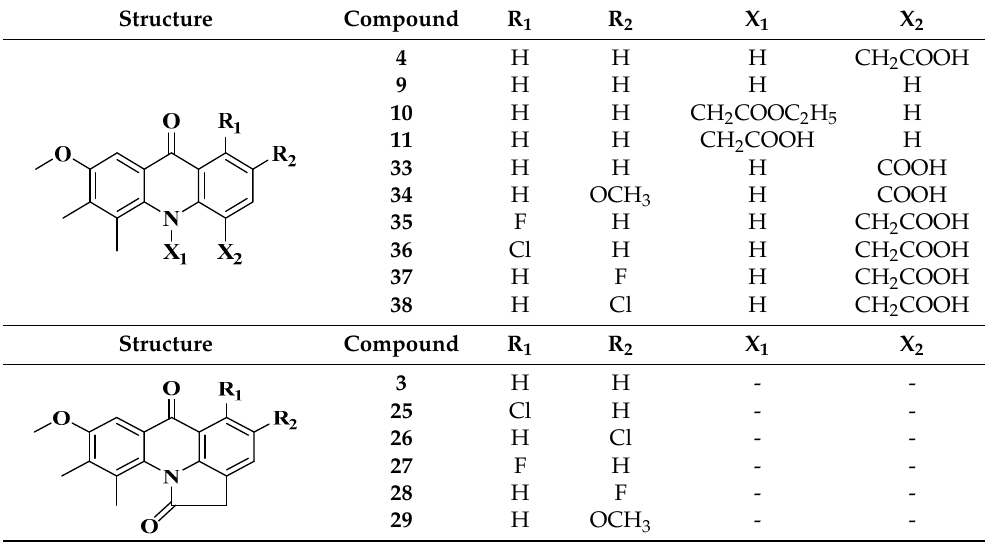
Table 2. The results of compounds with various hSTING isoforms and mSTING competition bind- ing assays. Compound